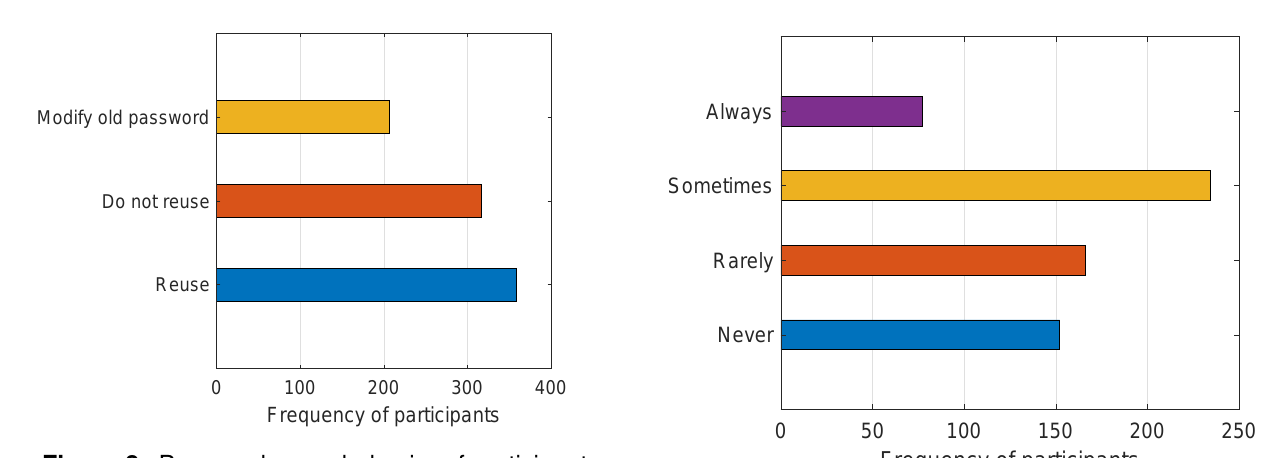
Figure 8. Password reuse behavior of participants Apart from those, the number of Bengali (mother tongue of participants) words written using English alphabet characters were approximately 9%.